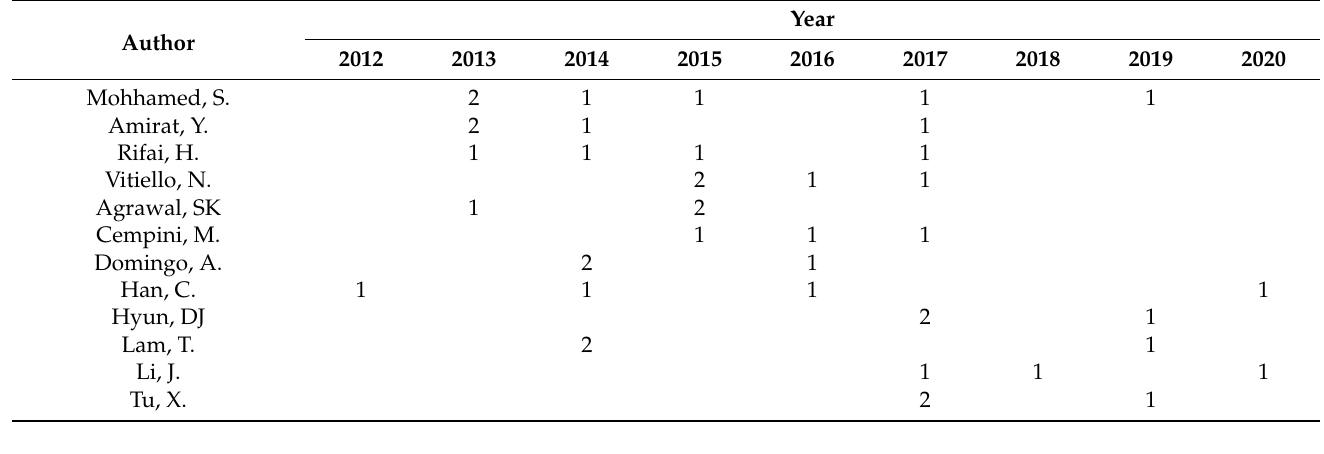
Table 4. Top authors’ production over time.